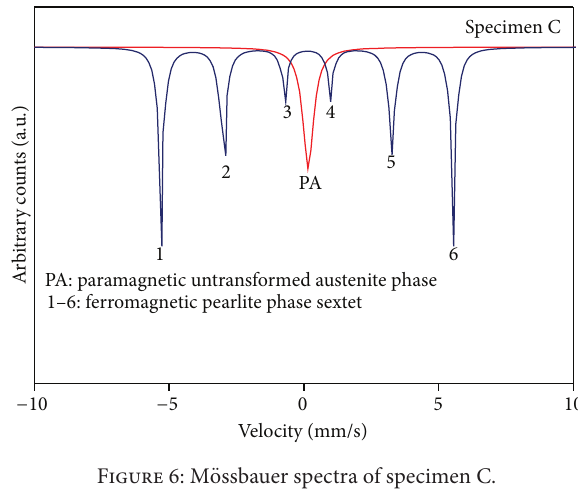
Figure 6: M¨ossbauer spectra of specimen